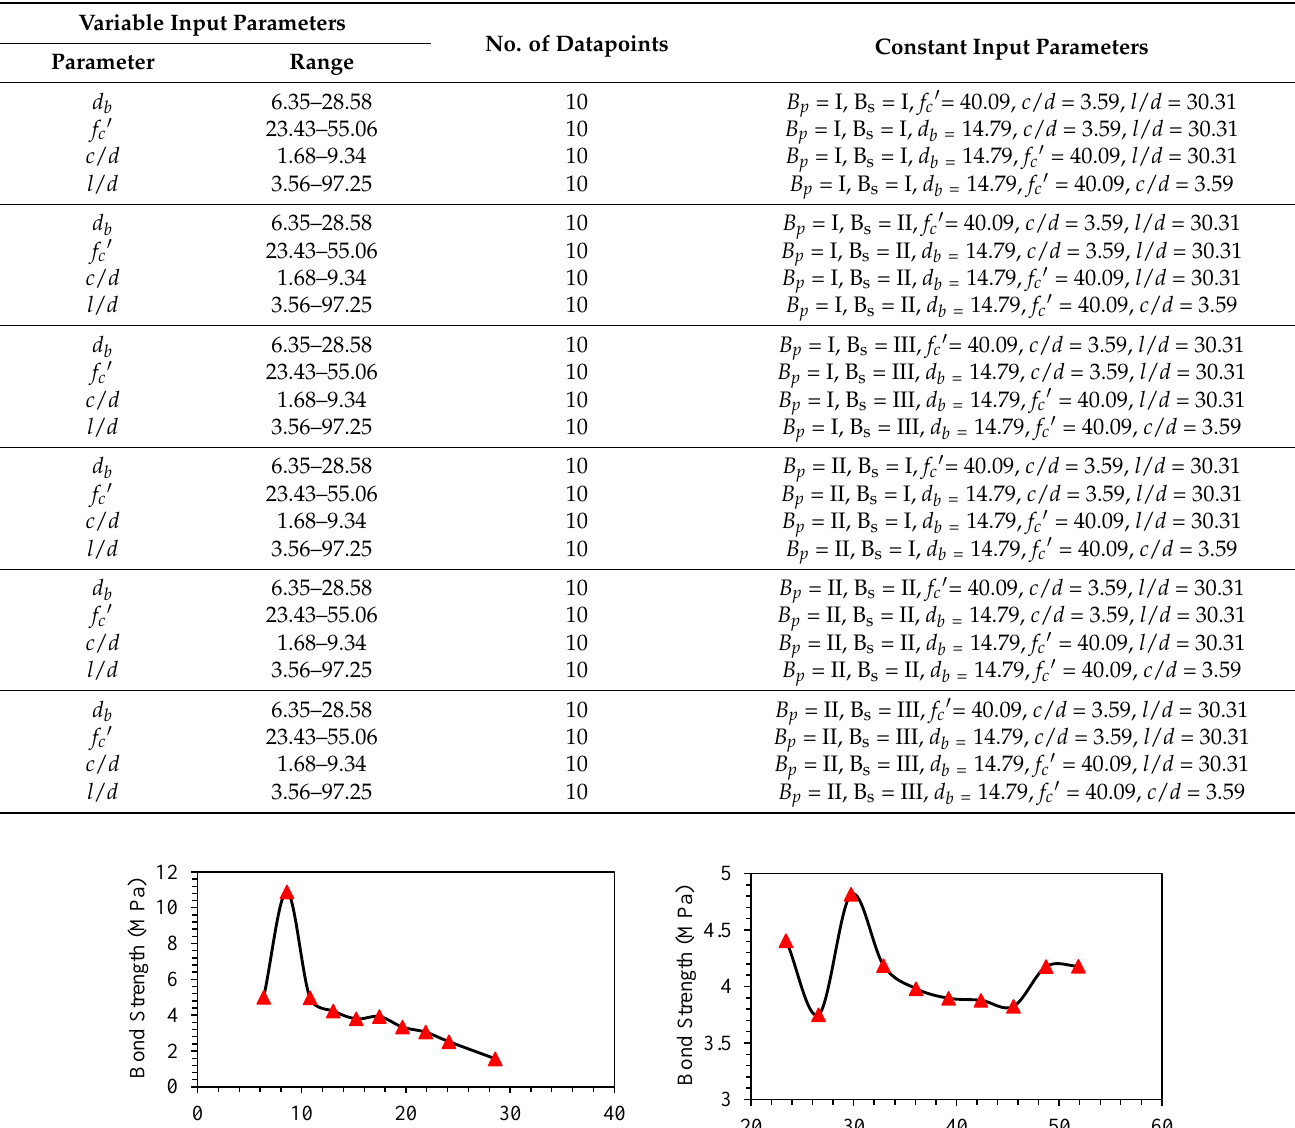
Table 4. Simulated dataset for parametric analysis.